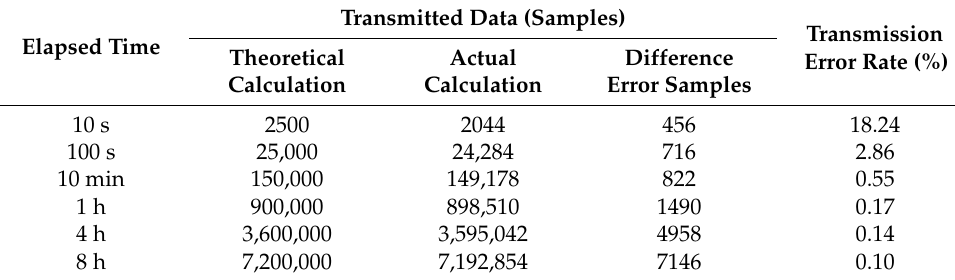
Table 5. Wireless data stream error ratio evaluation